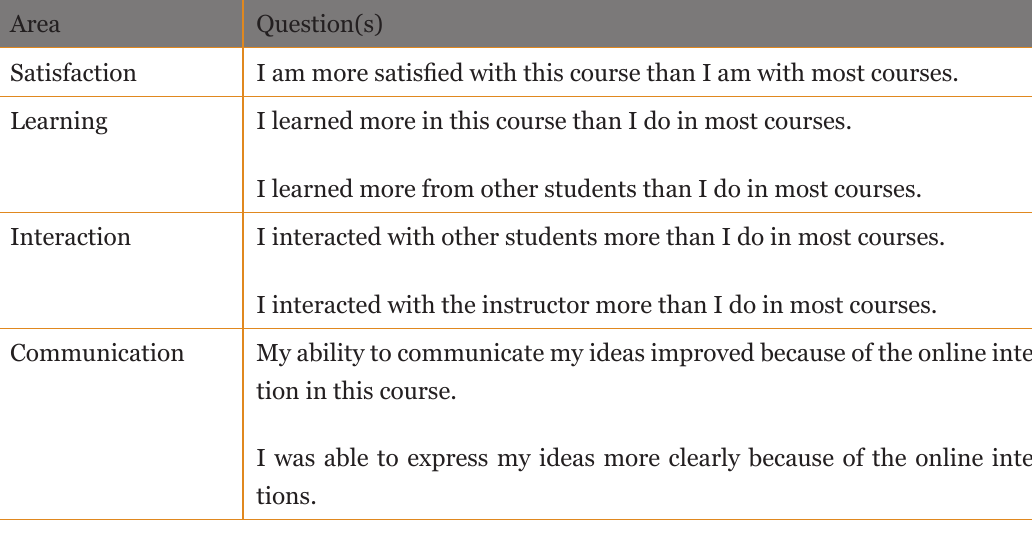
Questions Analyzed with Binary Logistic Regression